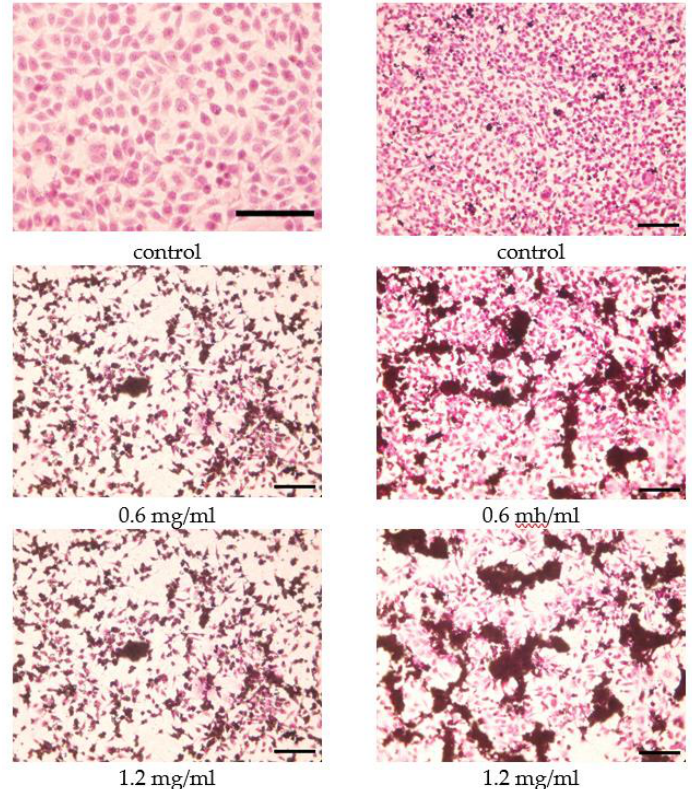
Figure 7. Microscopic images of L929 mouse fibroblasts after 24 h (left column) and 72 h (right column) of incubation with different concentration of ZSM-55. The cells were stained with eosin and hematoxylin. Scale bar: 100 nm.